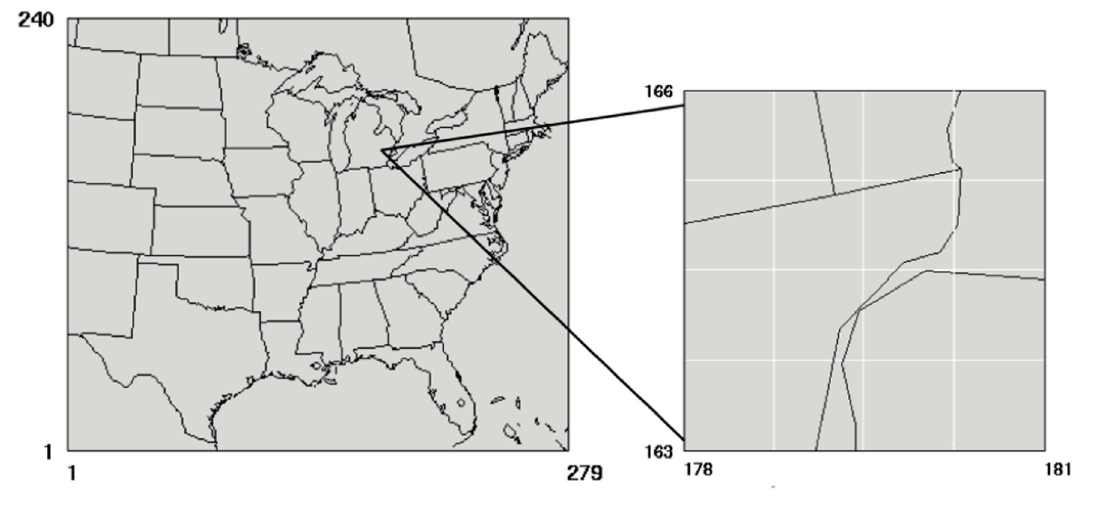
Figure 1. CMAQ modeling domain for the Eastern U.S. (left) and Detroit study domain (right). The Detroit grid shows the 16 12-km × 12-km grid cells where local sources were